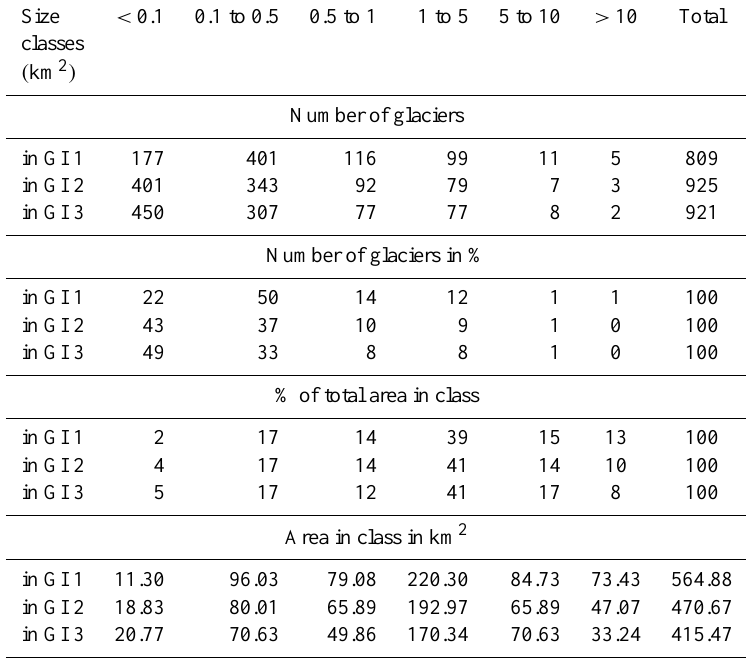
Table 4. Absolute and relative number and areas of glaciers per size class. Size < 0.1 0.1 to